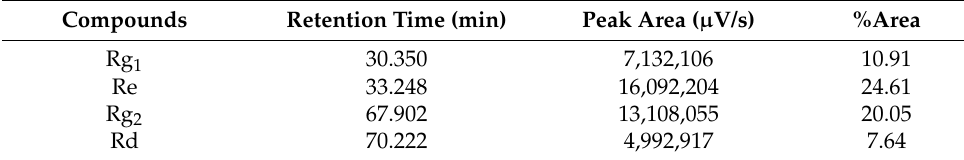
Figure 9. HPLC chromatograms of TG recorded at 203 nm. Table 3. Contents of the ginsenosides in TG.